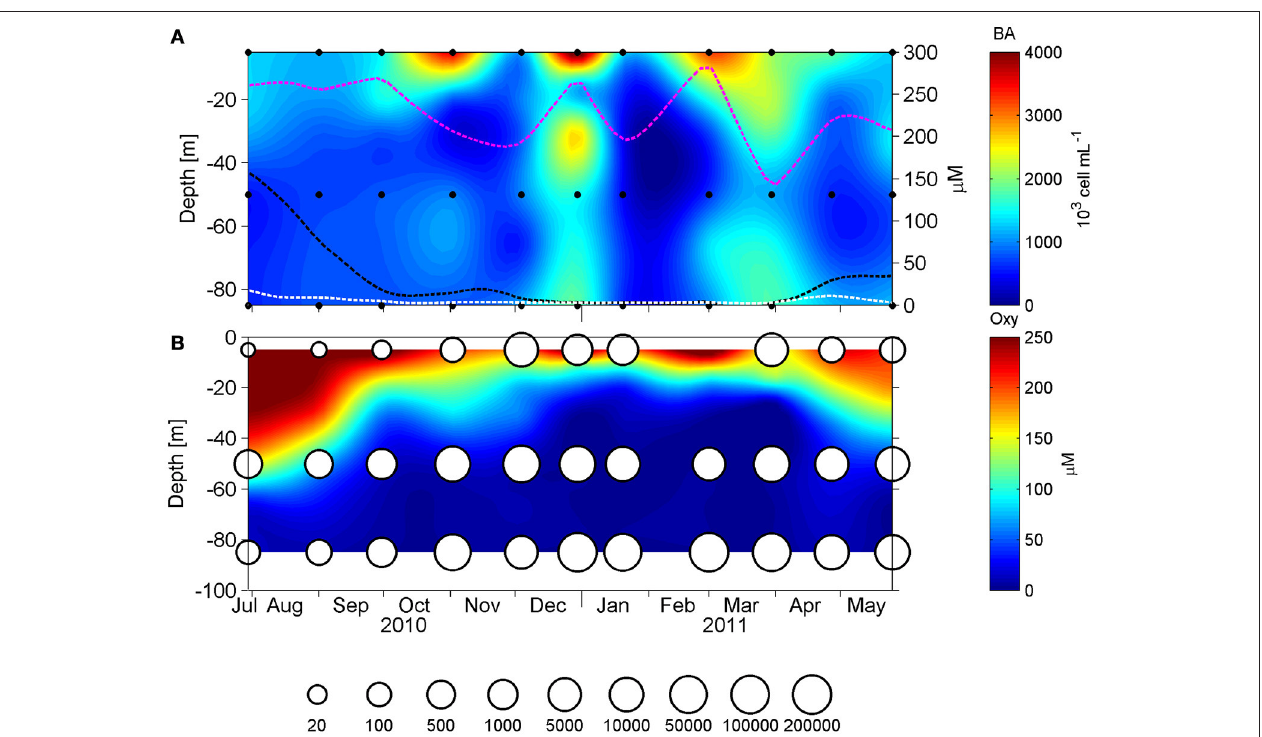
FIGURE 5 | Panel (A) shows the vertical distribution of the microbial abundance (10 3 cells mL − 1 ), measured by flow cytometry and in doted lines the fluctuation of oxygen during the annual cycle at 5 (pink), 50 (black), and 85m (white). Panel (B) shows the dissolved oxygen concentration ( µ M) with cbbM abundance (N ◦ copies mL − 1 ) presented as bubbles in a logarithmic scale, in 1 year long at St.